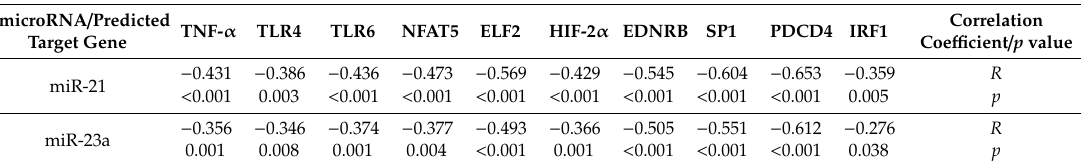
Table 2. Both miR-21-5p and miR-23a-3p gene expressions are negatively correlated with several predicted target gene expressions.